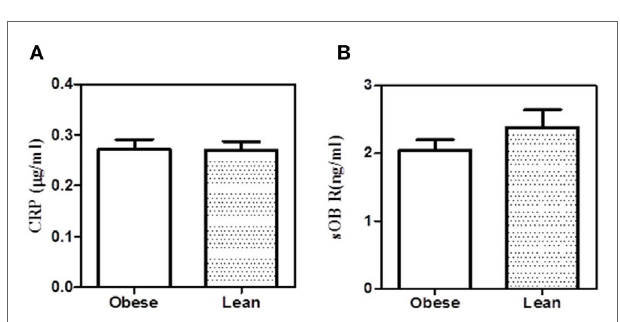
FigUre 8 | Co-precipitation of leptin receptor and C-reactive protein (CRP) from serum of obese and lean subjects. (a) Soluble leptin receptor (sOb R) was immunoprecipitated from the serum of lean ( n = 6) (body mass index, BMI < 23) and obese ( n = 5) (BMI > 25) male subjects and CRP estimated by ELISA as shown in Figure 3 . (B) CRP was immunoprecipitated from the serum of lean and obese male subjects and estimated sOb R by ELISA. Values given are the mean ± SD. p > 0.05 not significant.